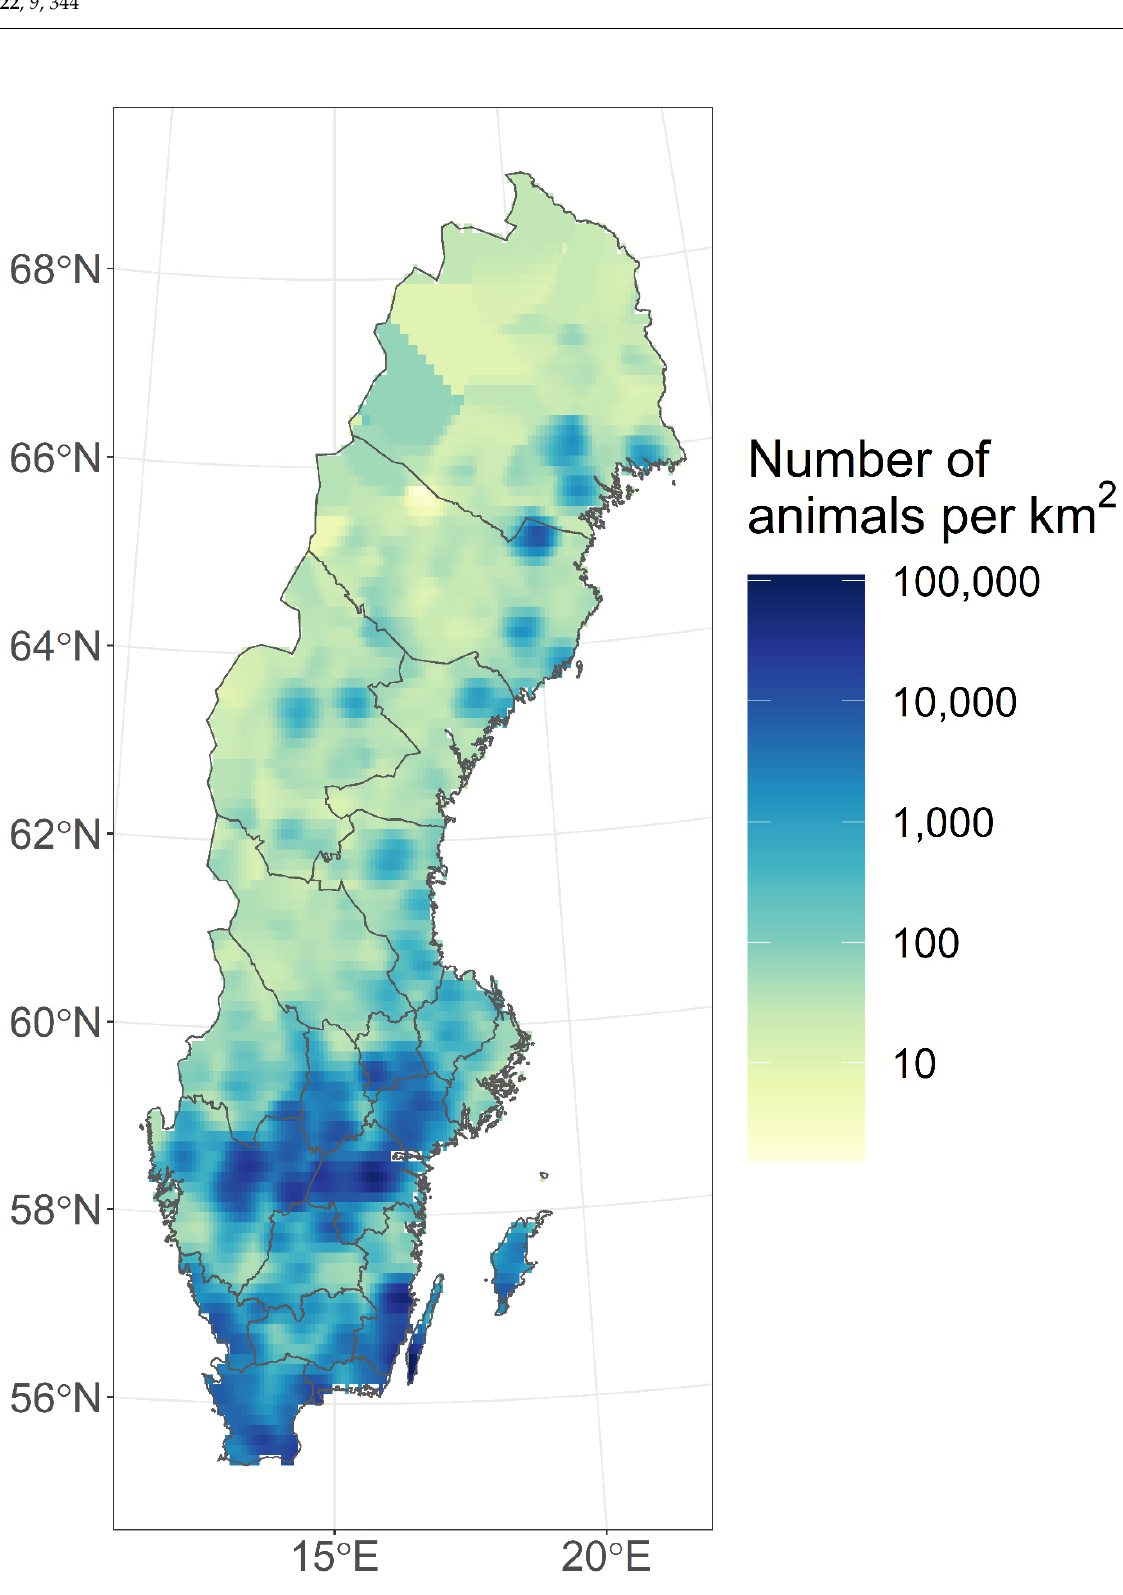
Figure 3. Map of Sweden showing domestic poultry density (number per square kilometre, colours in key). Map was created using kernel smoothing with a 10,000 m smoothing bandwidth over the value (animal count) at each point (farm identity (PPN)) location. Source: Swedish poultry register, Swedish Board of Agriculture.